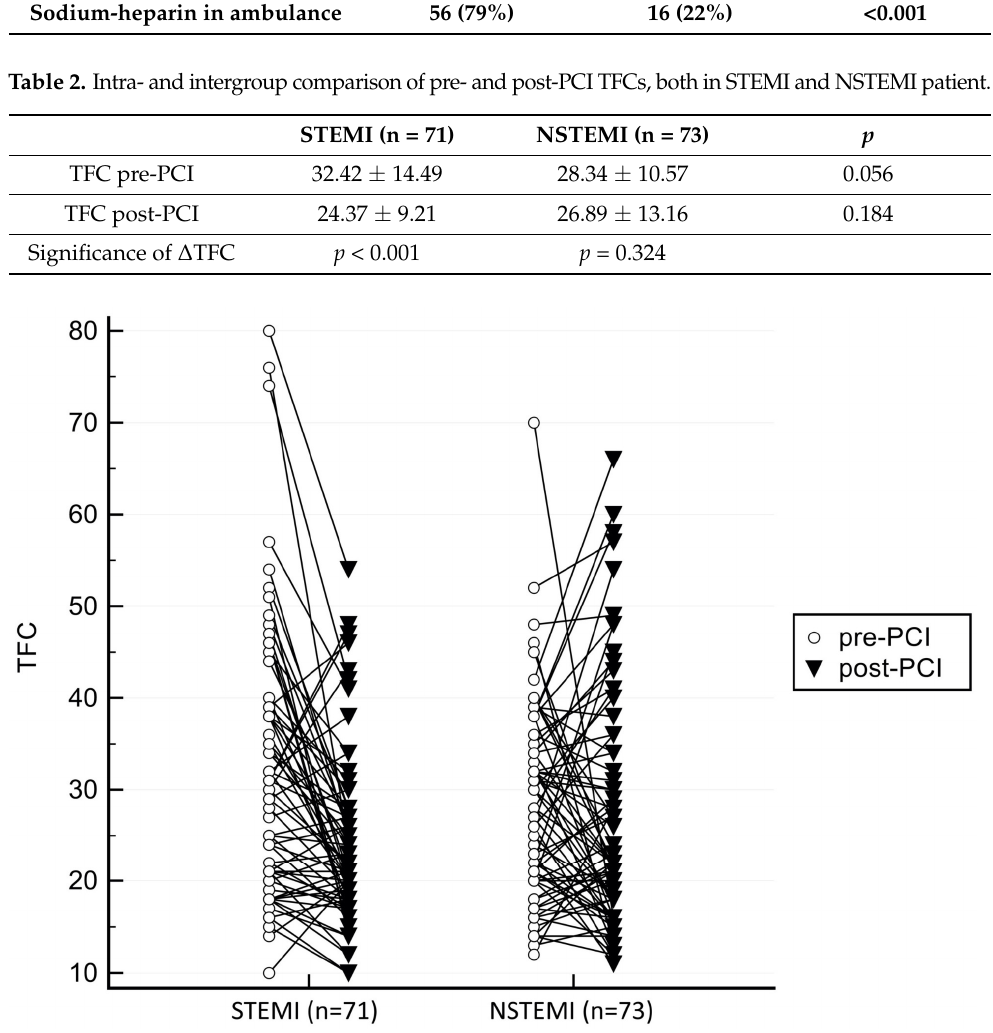
In case of intergroup comparison, we found significantly higher pre-PCI TFC in STEMI patient (32.42 ± 14.49 vs. 28.34 ± 10.57; p = 0,056). Evaluating the intragroup results,